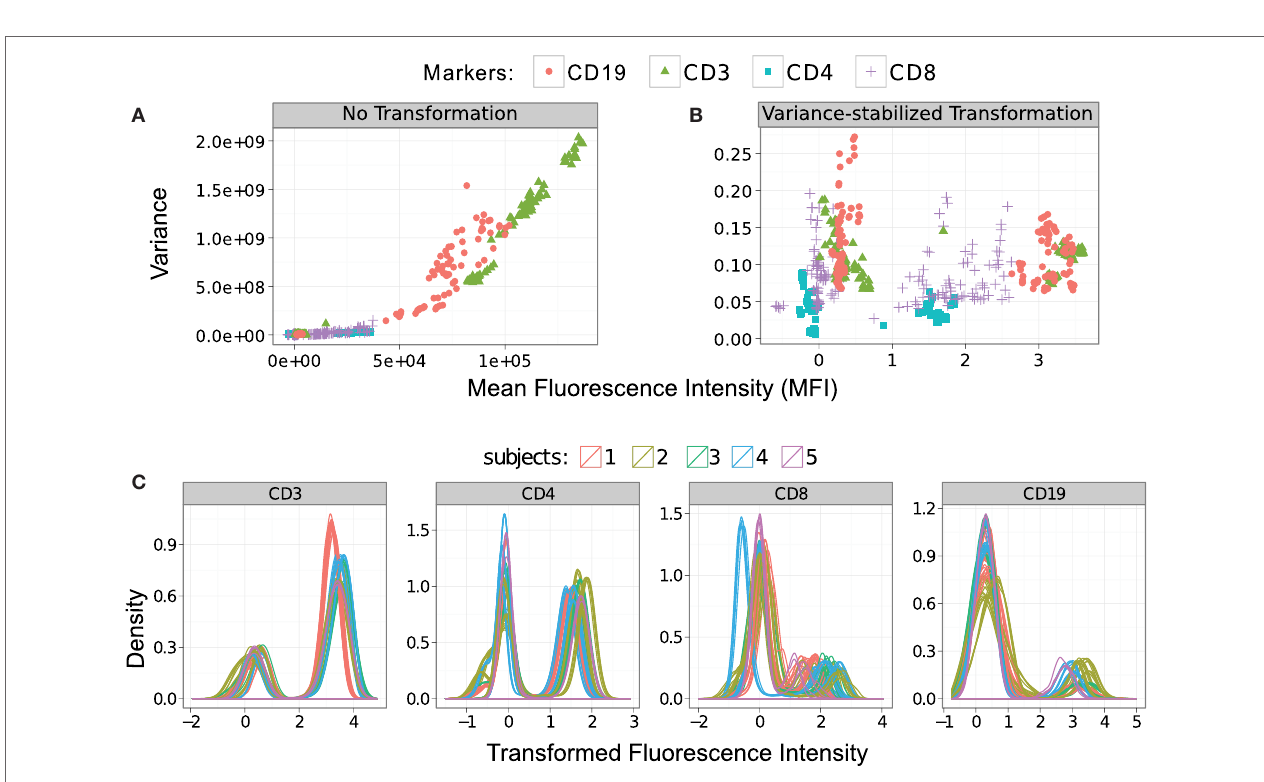
FigUre 6 | stabilizing the within-cluster variance for each channel of the hD dataset . (a) Variances of the clusters increase monotonously with their means before the variances are stabilized. Clusters in each marker are shown with the same symbol and color. (B) Variances are approximately stabilized for each marker/ channel after the data are transformed by the asinh function with the optimum cofactor. (c) Density of the variance-stabilized fluorescence channels are plotted where different subjects are denoted with different